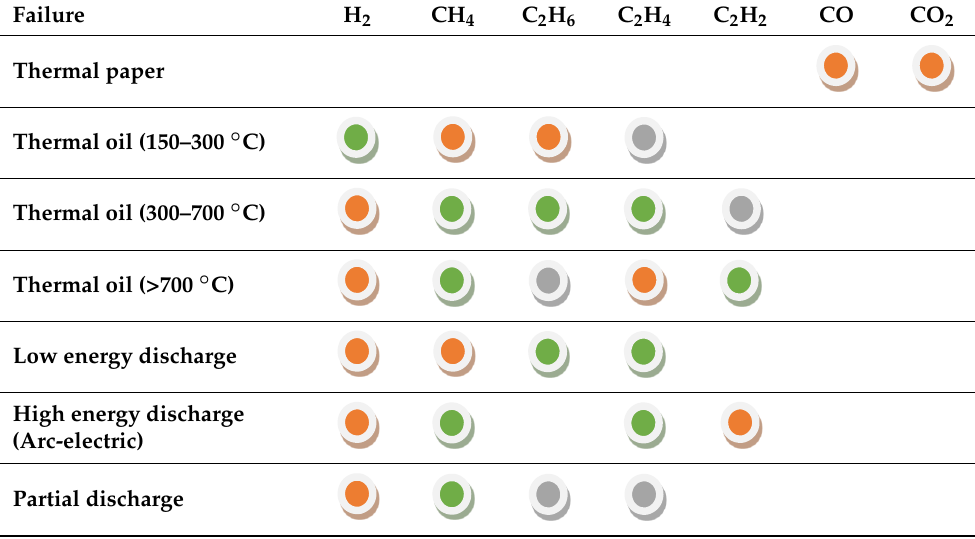
Table 3. Standardization regarding gases produced in the transformer and associated failures.